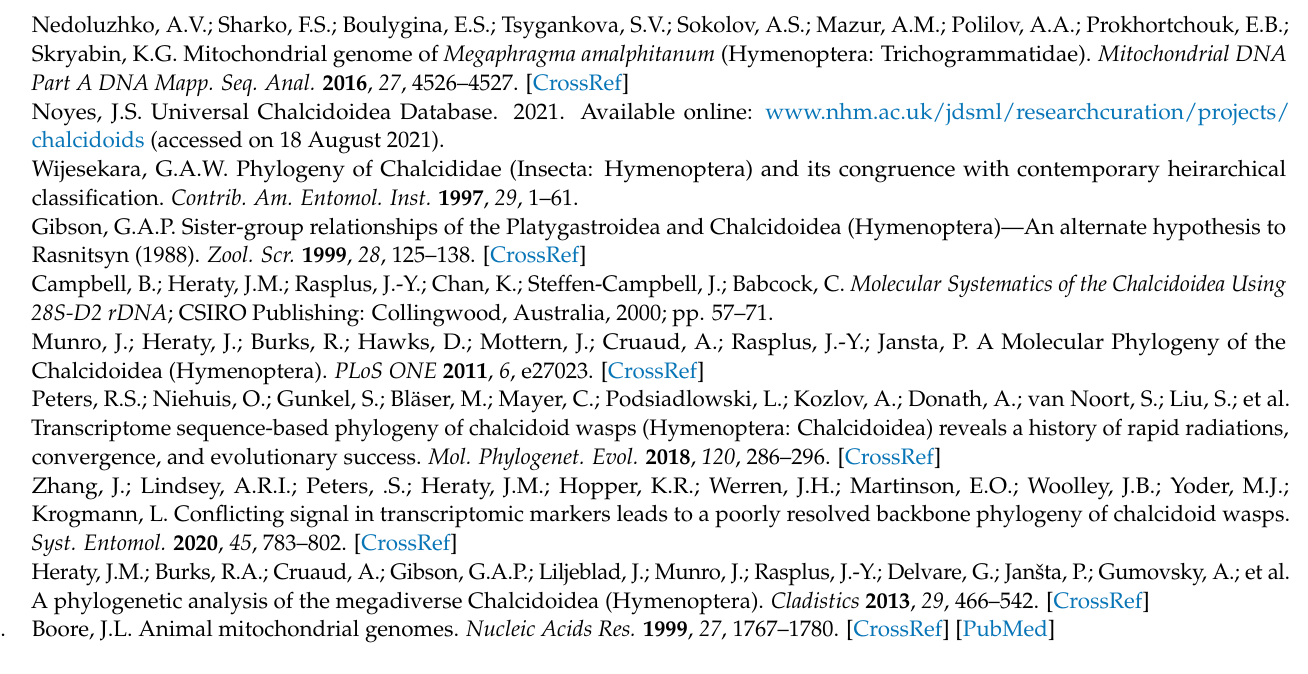
Figure S4: Phylogenetic relationships among Chalcidoidea species by BI analysis based on the PCG12 dataset, Figure S5: Phylogenetic relationships among Chalcidoidea species by ML analysis based on the PCG12